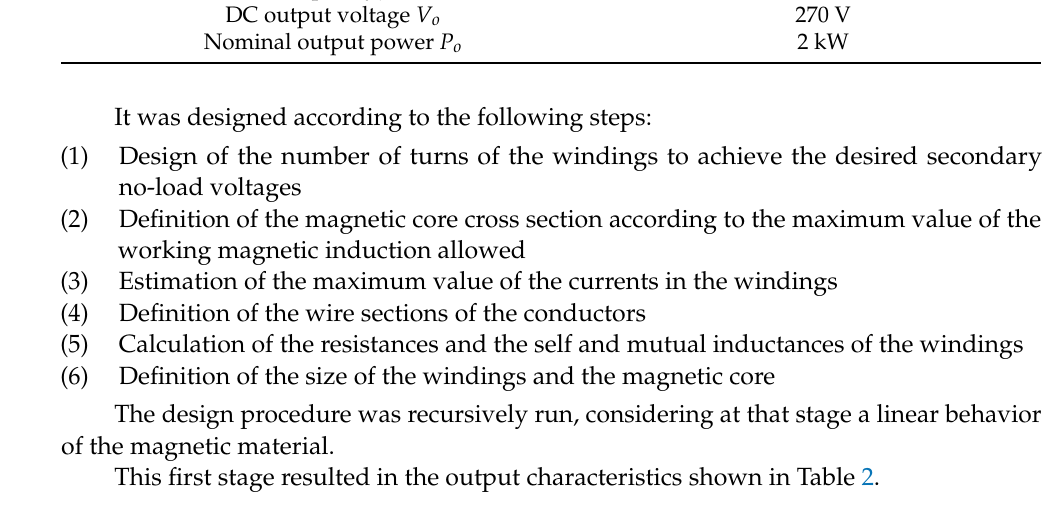
Table 2. Conventional 12-pulse unit